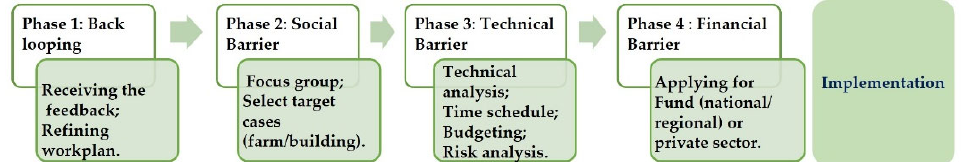
Figure 13. The scheme illustrates the following milestones based on the findings of this research and the first author’s PhD study